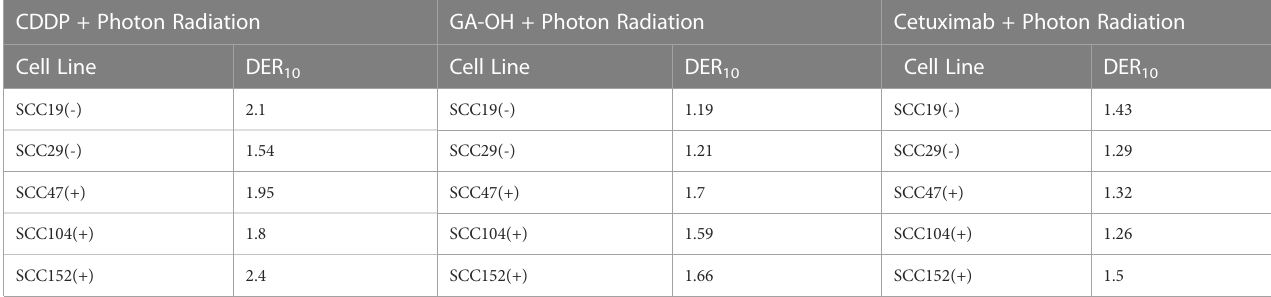
TABLE 1 Dose enhancement ratios (DER 10 ) of X-ray photon radiation with either CDDP, GAOH or cetuximab calculated at SF of 0.1. CDDP + Photon Radiation GA-OH + Photon Radiation Cetuximab + Photon Radiation Cell Line Cell Line DER 10